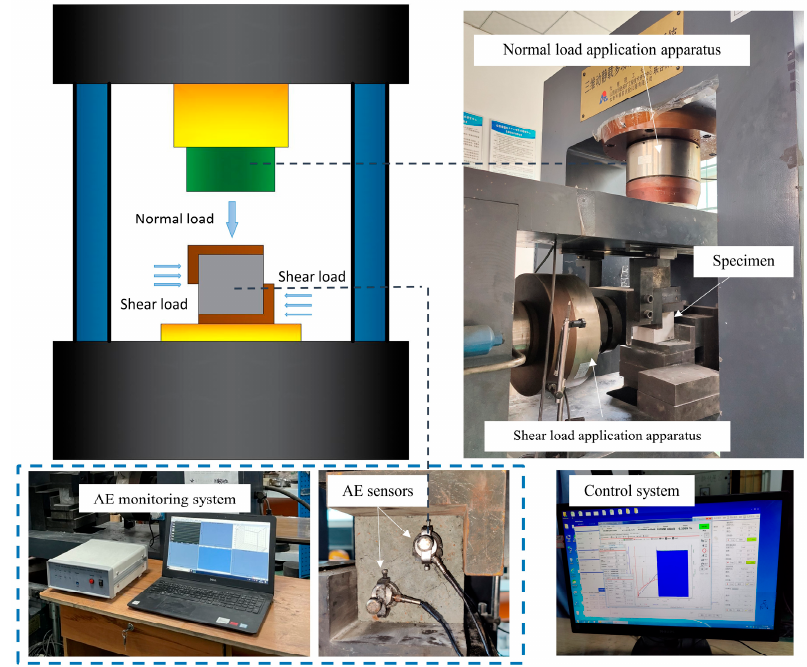
Figure 2. Testing system.